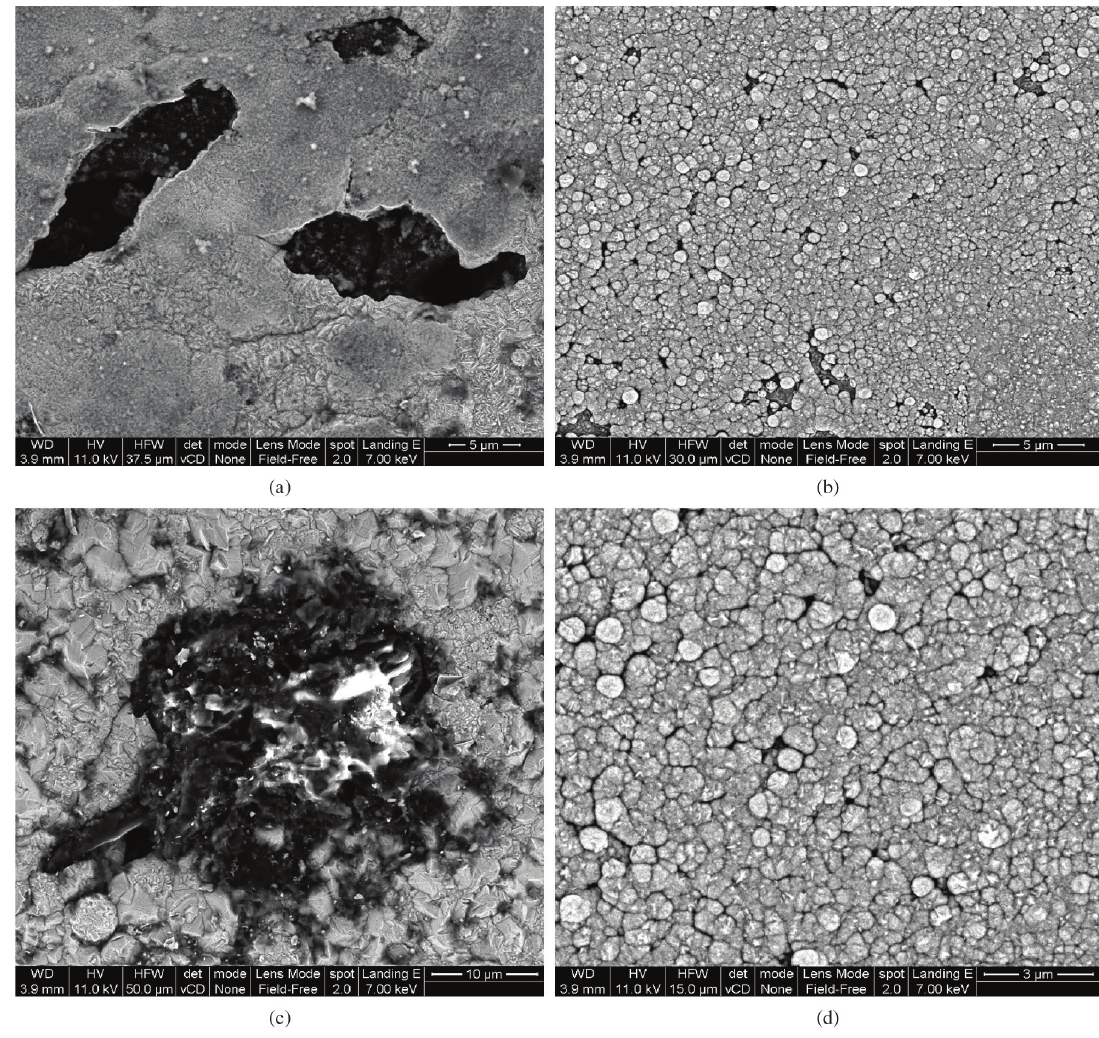
Figure 5. Surface morphology of Ni electrodeposit after polarization. (a) Coarse and (b) fine Ni on untreated carbon steel. (c) Coarse and (d) fine Ni on inhibitor-treated